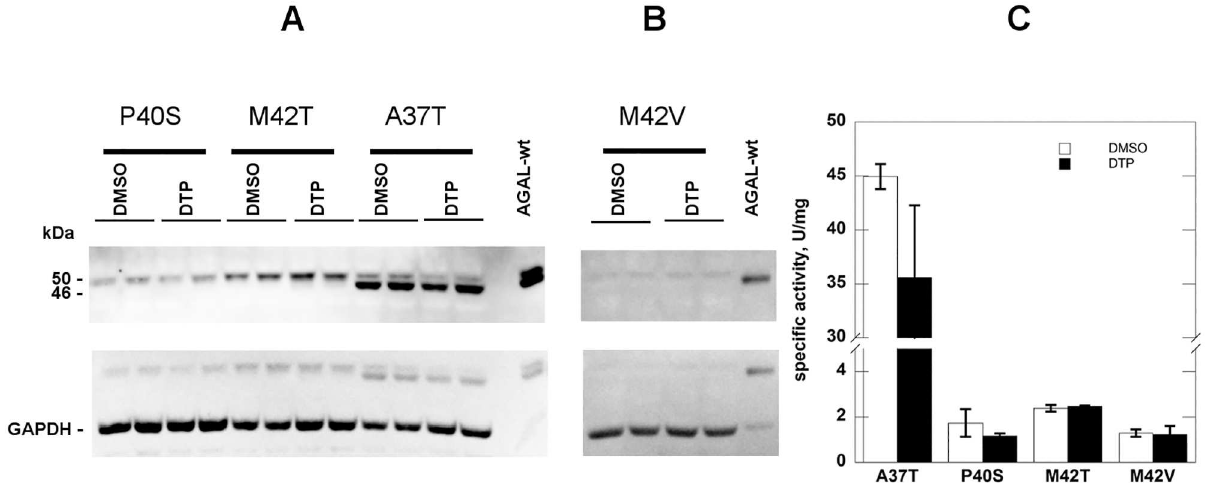
Fig 7. 2–6 dithiopurine has no effect on mutations affecting the allosteric site. COS-7 cells were cultured in conventional medium and transfected with plasmid containingA37T, P40S, M42T, M42V mutants. Cells were treated with DTP 6 mM dissolved in DMSO and an appropriate control was realized. After 48 h incubation,the cells were scraped and lysed then water-soluble extracts were analysedby western blotting (A and B) and enzyme assay (C). Standarddeviationsare indicatedby